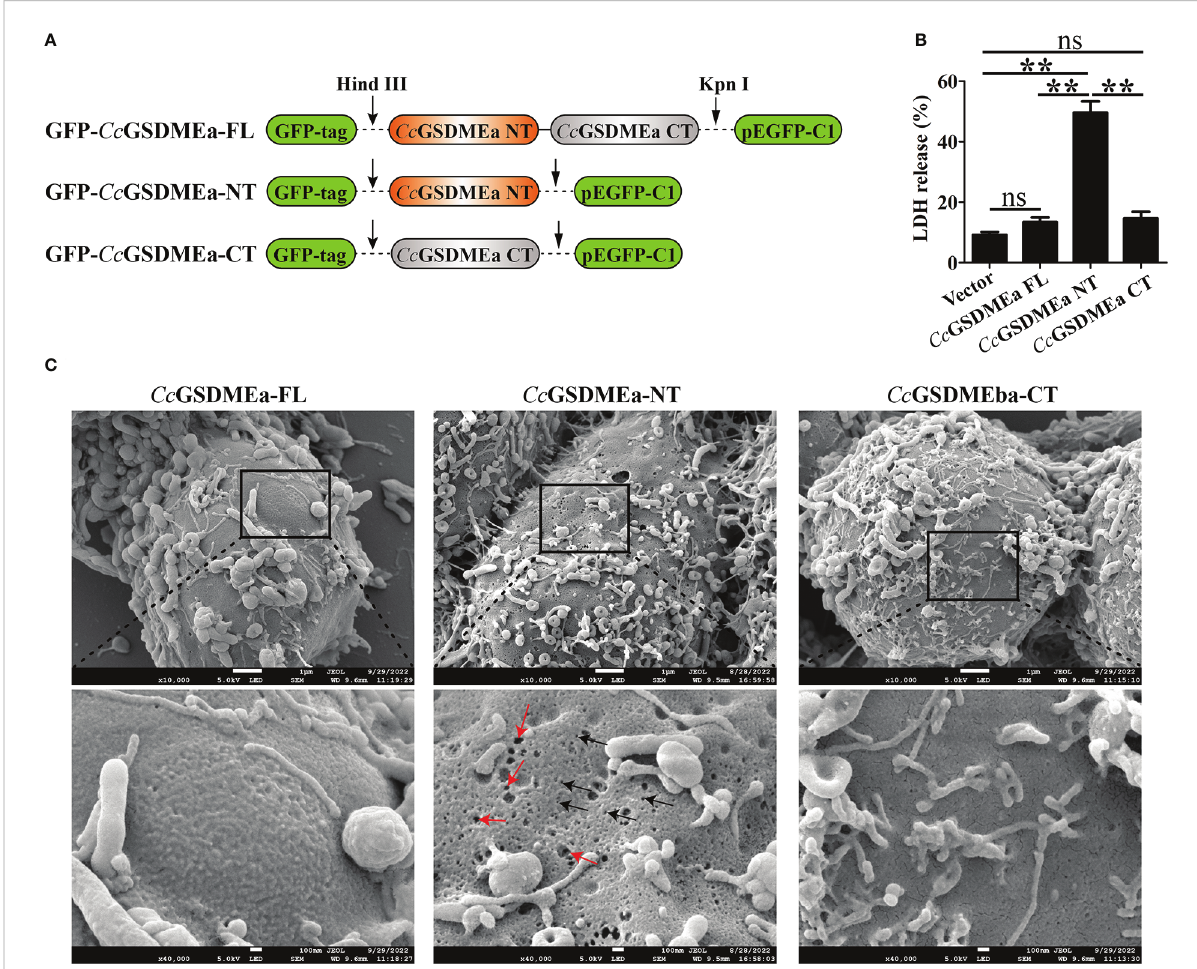
FIGURE 4 Membrane pore formation induced by Cc GSDMEa-NT in HEK293T cells. (A) Schematic diagram of the recombinant plasmids of Cc GSDMEa-FL (1-532 AA), Cc GSDMEa-NT (1-250 AA), Cc GSDMEa-CT (257-532 AA) and pEGFP-C1. (B) LDH release from cells transfected with 1000 ng of different forms of Cc GSDMEa recombinant plasmids. (C) Morphological observation of HEK293T cells transfected with different forms of Cc GSDMEa recombinant plasmids. Red arrows display cell plasma membrane rupture, and dark arrows indicate the membrane pores induced by Cc GSDMEa-NT. The LDH release values are shown as M ± SD (n = 3). The signi fi cant differences were analyzed by student ’ s t test, “ ** ” means P < 0.01, “ ns ” means no signi fi cant